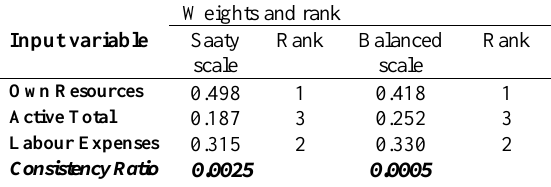
Table 5. Input weights obtained with two